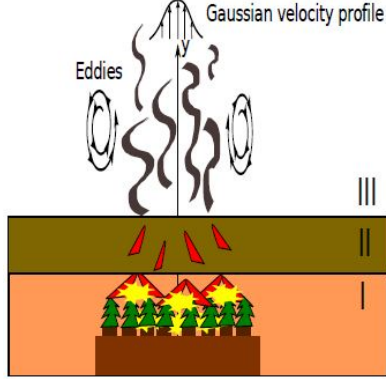
Figure A1. Sketch of the Baum and McCaffery plume. Region I is the continuous (canopy) burning region. Region II is a transition zone over which the plume velocity is constant. The buoyant upward motion in region III is reinforced by large ambient eddies, which cause entrainment of air into the